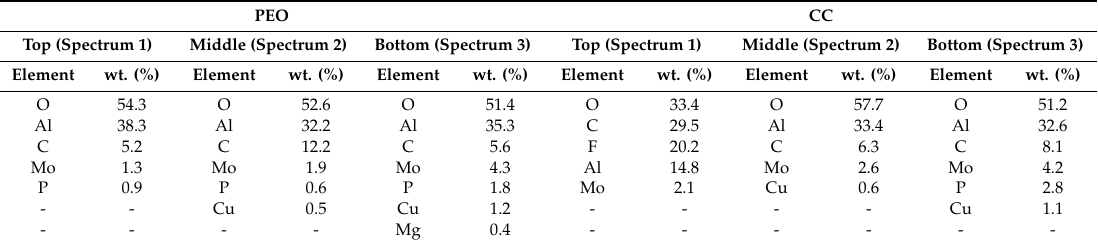
Table 2. Elemental composition at di ff erent locations across coatings’ thickness (Figures 4 and 5). PEO CC Top (Spectrum 1) Middle (Spectrum